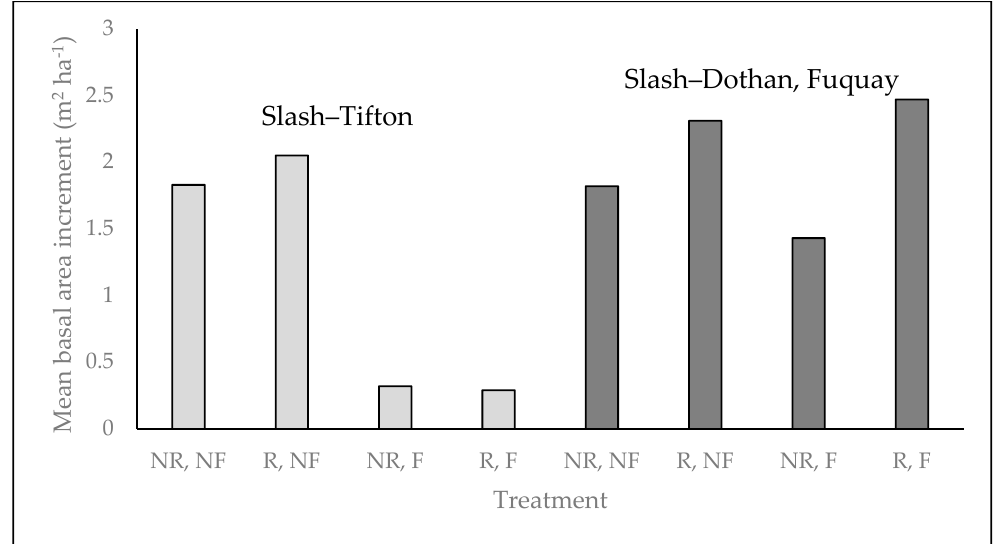
Figure 11. Mean basal area increment over the five-year study period for two slash pine sites by treatment [25]. Treatments: no rake, no fertilization (NR, NF); rake, no fertilization (R, NF); no rake, fertilization (NR, F); rake, fertilize (R, F) (refer to Tables 6 and 7 for study details, information on fertilizer treatments, and statistical test results).